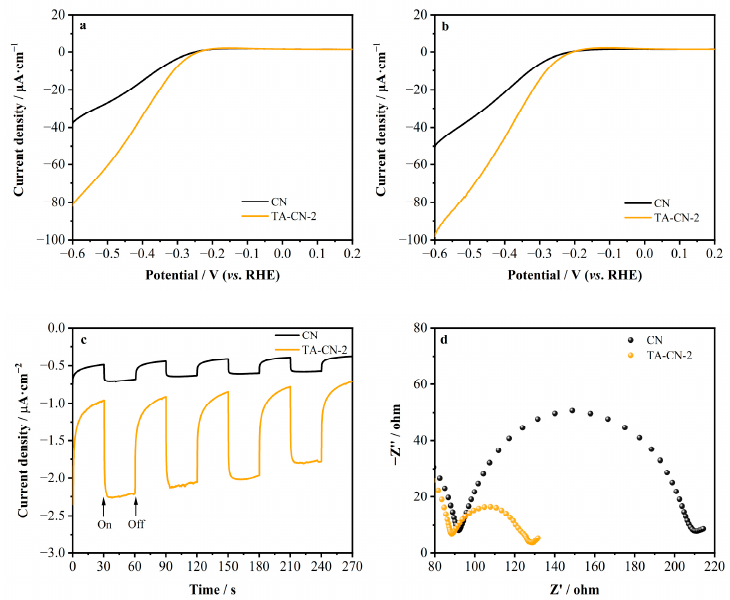
Figure 8. ( a ) LSV curves without visible light irradiation; ( b ) LSV curves with visible light irradia- tion; ( c ) transient photocurrent response curves under visible light irradiation and ( d ) EIS Nyquist plots of CN and TA-CN-2.